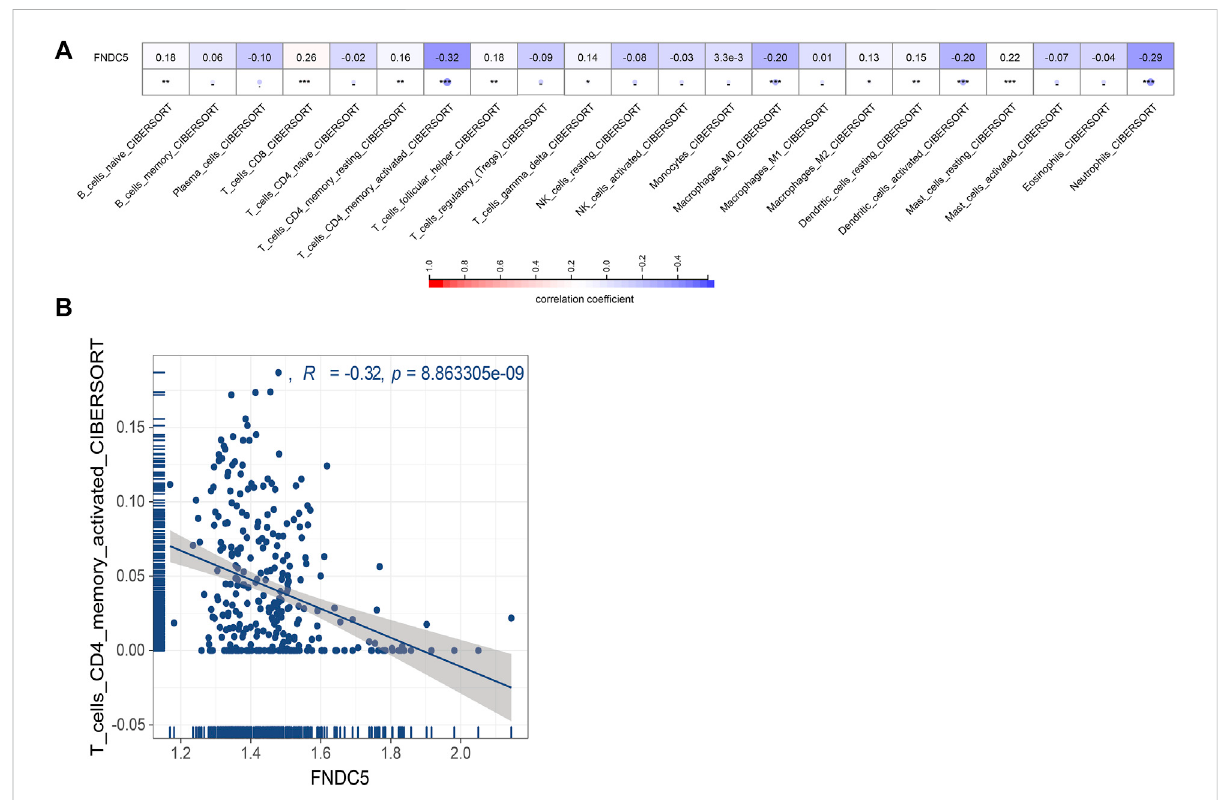
FIGURE 3 Correlations between FNDC5 and tumor immune microenvironment. (A) The association between FNDC5 and different immune cells. (B) Correlation between FNDC5 and T cells CD4 memory activated. *, p < 0.05; **, p < 0.01; ***, p <